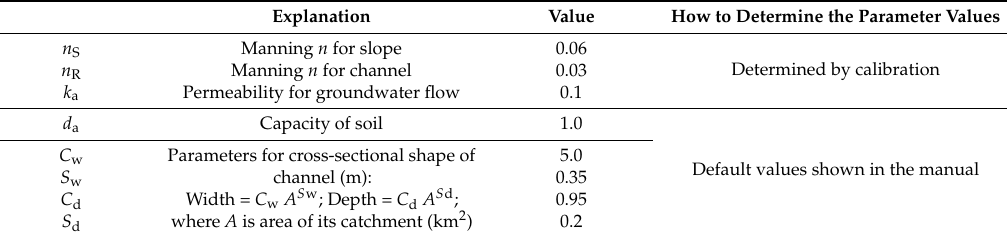
Table 2. List of parameters of the Rainfall-Runoff-Inundation (RRI) model used in this study. Explanation Value How to Determine the Parameter Values n S Manning n for slope 0.06